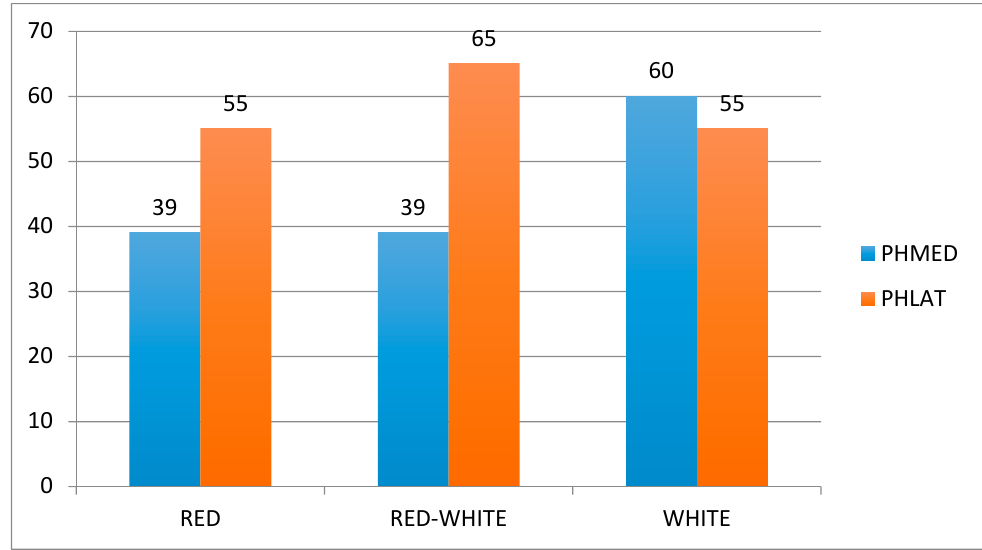
Figure 5. Statistically significant di ff erence between baseline and posttreatment T2